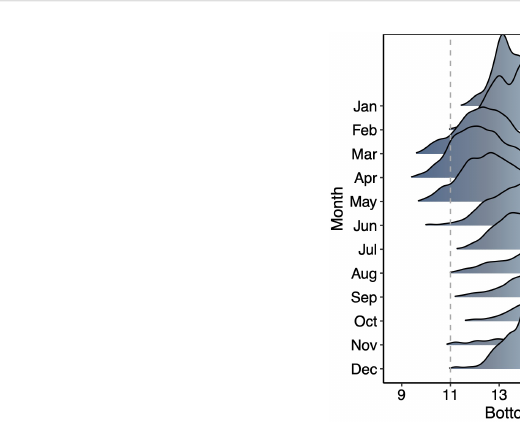
FIGURE 1 Temporal Variation in Bottom Temperature. Monthly bottom (4.5 m depth) temperatures at Mohawk Reef (34.396290, -119.731297) in Santa Barbara, CA compiled from 2005-2017. Vertical dashed lines represent three of four treatment temperatures (11, 16, 21°C). Data Source: Santa Barbara Coastal Long- Term Ecological Research